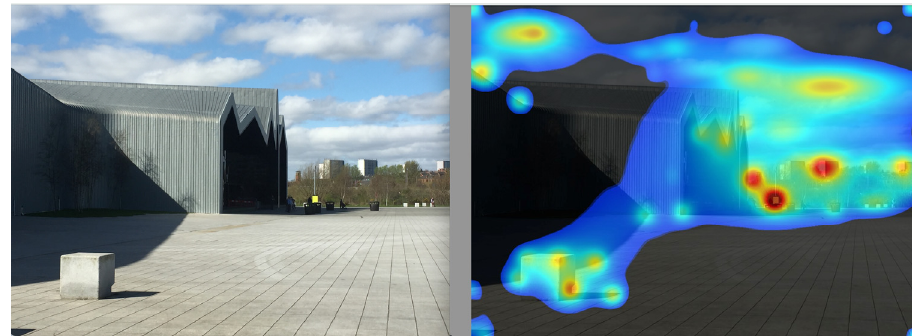
Figure 12. RSM main entrance from a distance. (Photo by A. Salama; VAS heatmap scan by N.A. Salingaros)